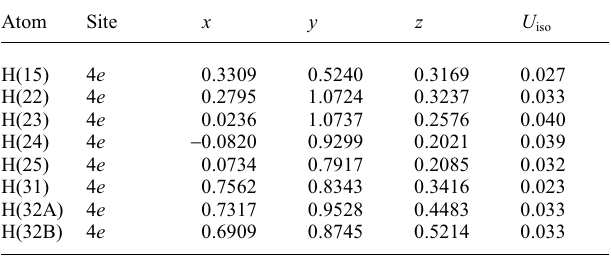
Table 3. Atomic coordinates and displacement parameters (in Å 2 )